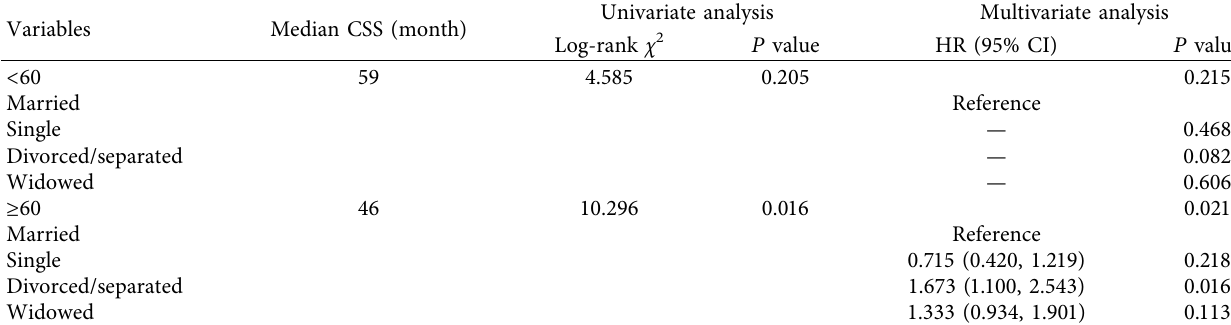
Table 9: Multivariate analysis for evaluating the influence of marital status on CSS according to